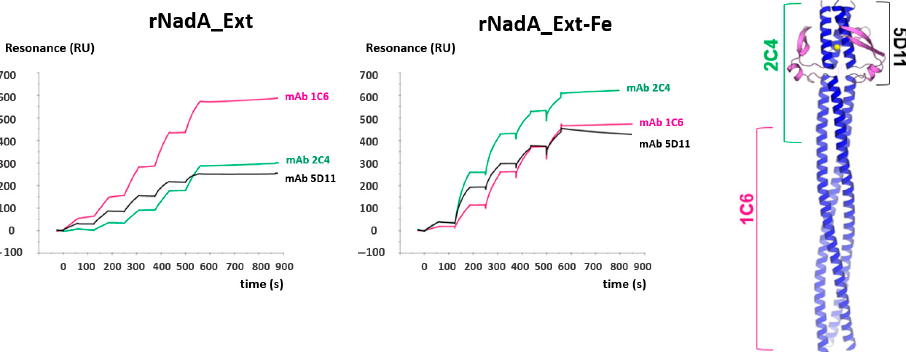
Figure 3. mAb recognition of conformational epitopes on NadA ectodomain, uncoupled and coupled to ferritin scaffold. ( Left ) SPR sensorgrams showing the binding of mAbs that recognize conformational epitopes on the N-terminal globular head domain (2C4, green SPR profile; 5D11, black profile) and stalk (1C6, pink profile) of free recombinant NadA (rNadA) and NadA-ferritin (NadA_Ext-Fe) RU = resonance units; s = seconds. ( Right )—Mapping of antibodies onto the NadA structure as reported by Giuliani et al. [29].